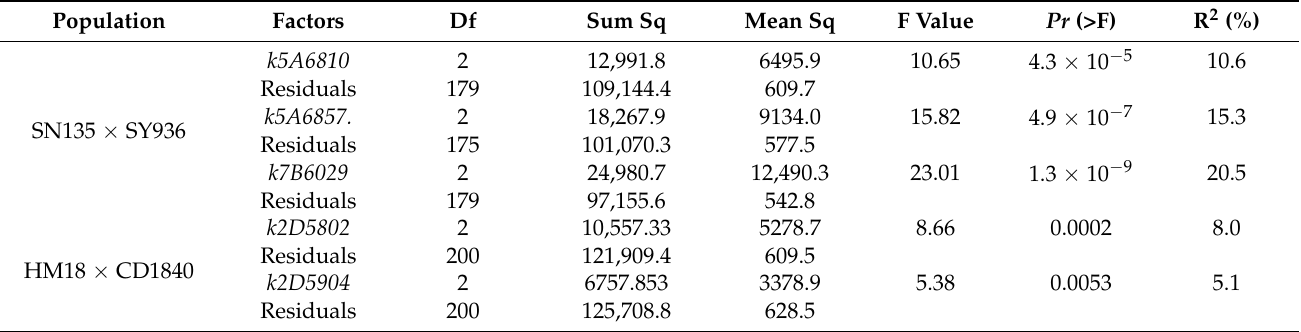
Table 3. Analysis of variance for five KASP assays conducted in the two segregation